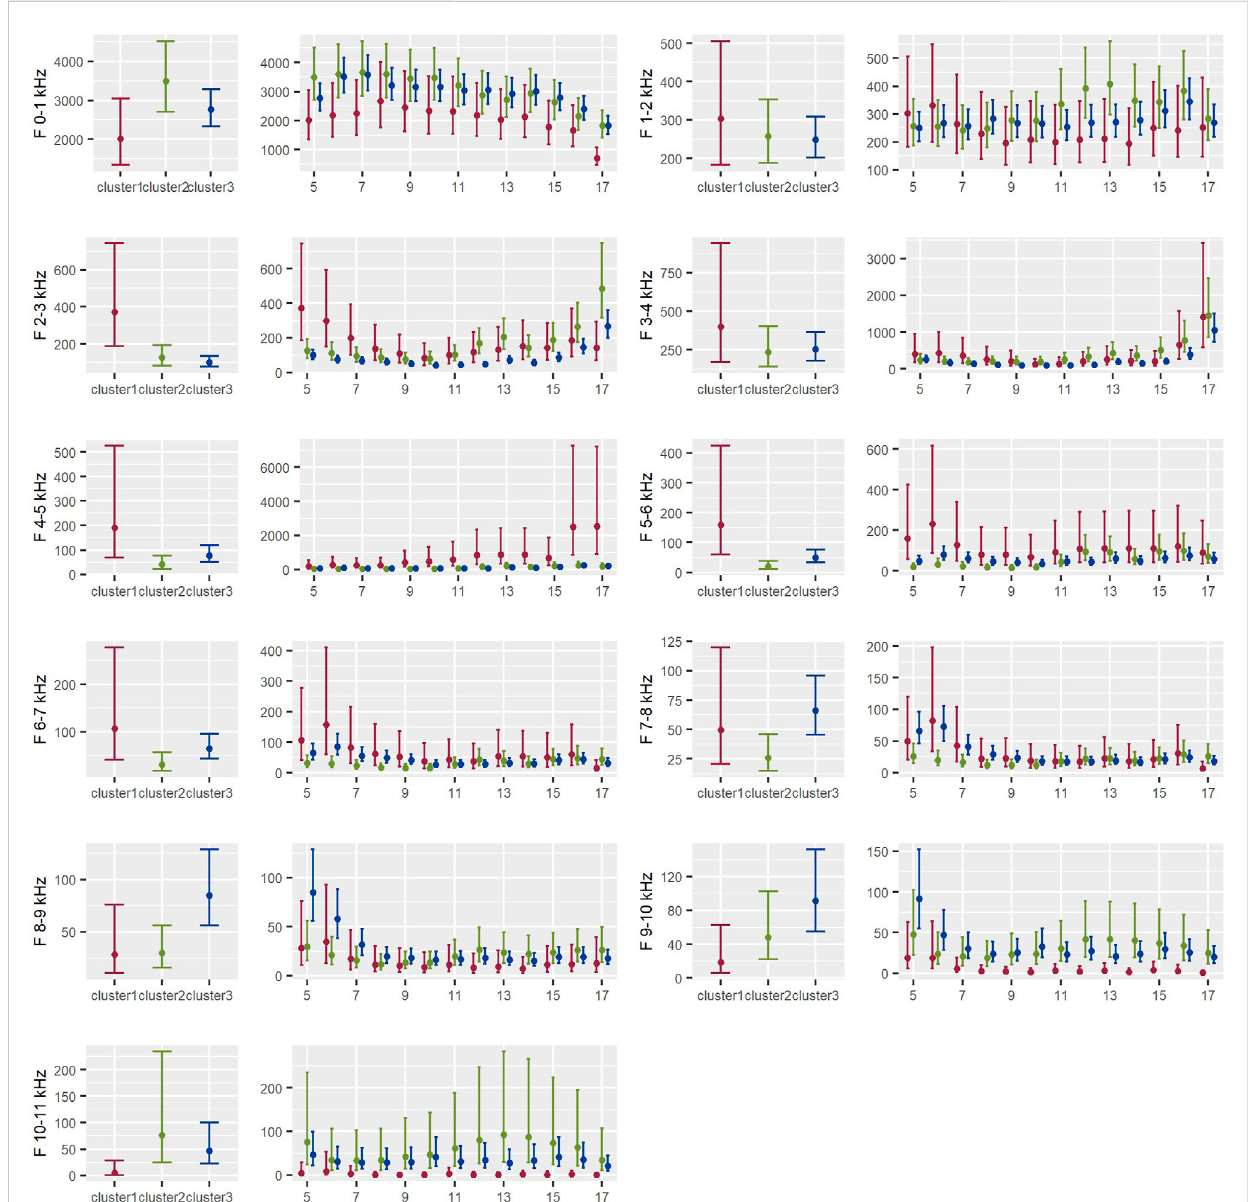
Distribution of dominant frequencies between clusters during the day in the Central Conservation Area of Costa Rica, 2019 – 2020.